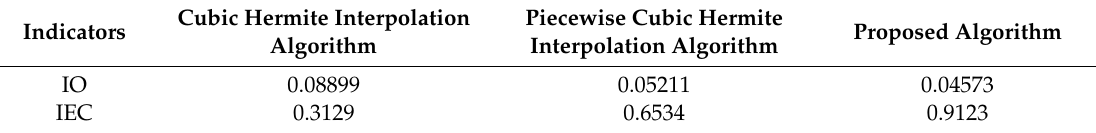
Table 2. Calculation results.